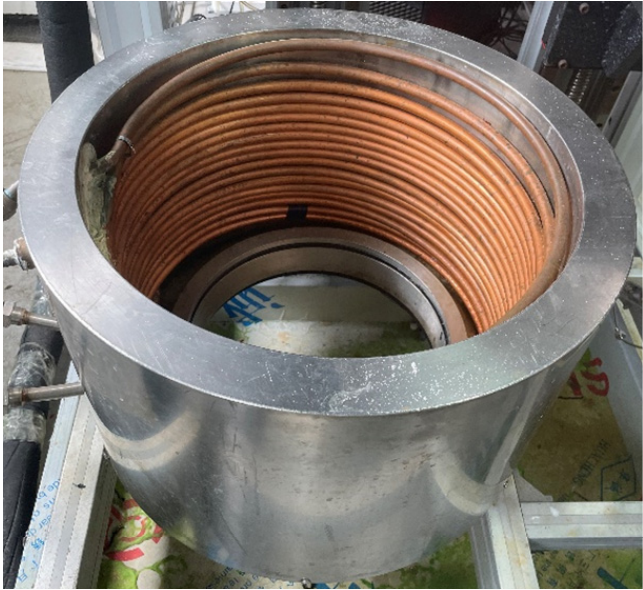
Figure 8. Schematic diagram of the temperature control water bath for the LSC.